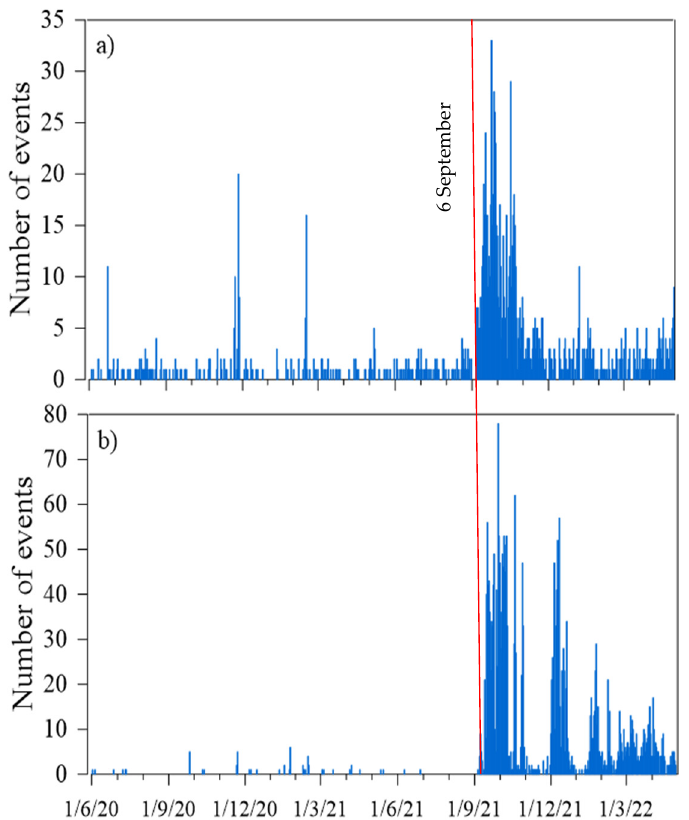
Figure 13. The daily occurrence rate of the local seismicity ( a ) with a frequency peak in the range of 1–30 Hz and ( b ) with a frequency peak < 1 Hz from 1 June 2020 to 30 April 2022. To meet monitoring and surveillance needs, a real-time automatic system for the detection, characterization, and source location of the events with a VLP component was implemented (see Section 2.8). This analysis allowed us to detect their source north of the La Fossa cone, in the Forgia Vecchia, at an altitude between − 1.5 and 0.5 km, with an average value of − 0.950 + − 0.27 km (Figure 14).